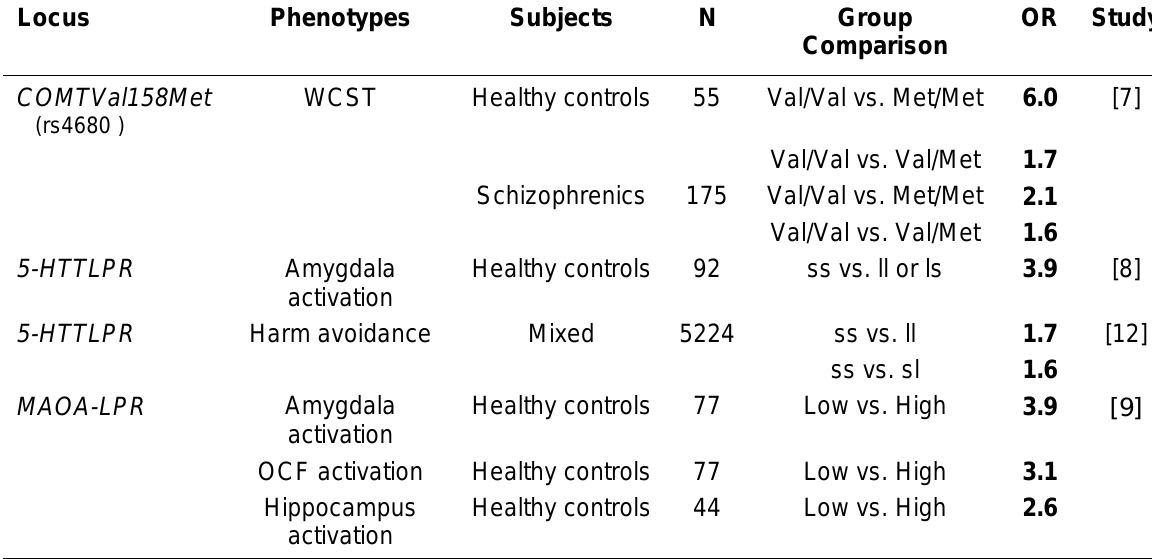
Effect Sizes of Three Functional Loci on Different Intermediate Phenotypes for Psychiatric